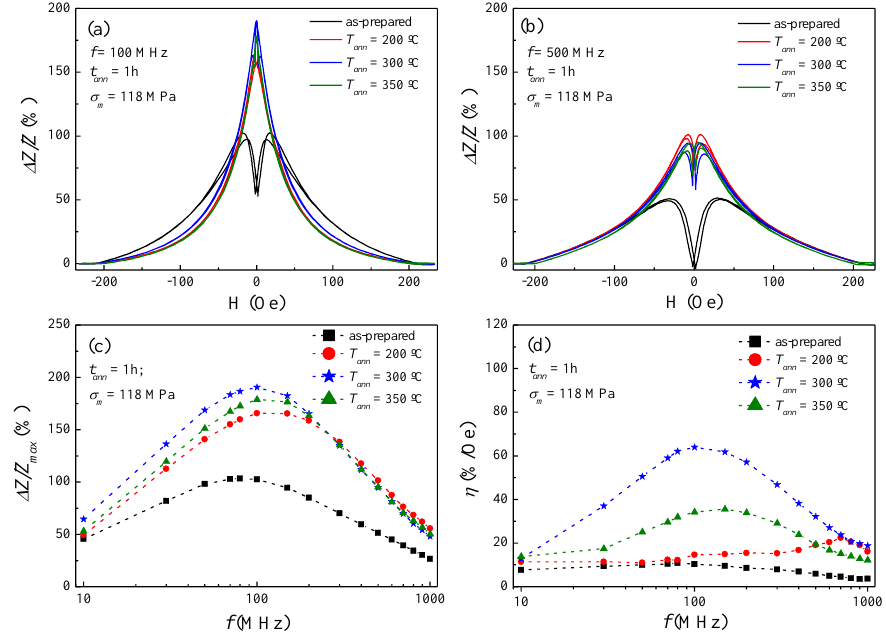
Figure 4. Field dependence of the GMI ratio for the as-prepared and 118 MPa stress-annealed Co 69.2 Fe 3.6 Ni 1 B 12.5 Si 11 Mo 1.5 C 1.2 microwires measured at representative frequencies: ( a ) 100 MHz and ( b ) 500 MHz; ( c ) frequency dependence of ΔZ/Z max , and ( d ) field sensitivity. Dashed-lines in ( c ) and ( d ) are a guide to the eye, while full-symbols denote experimental data.